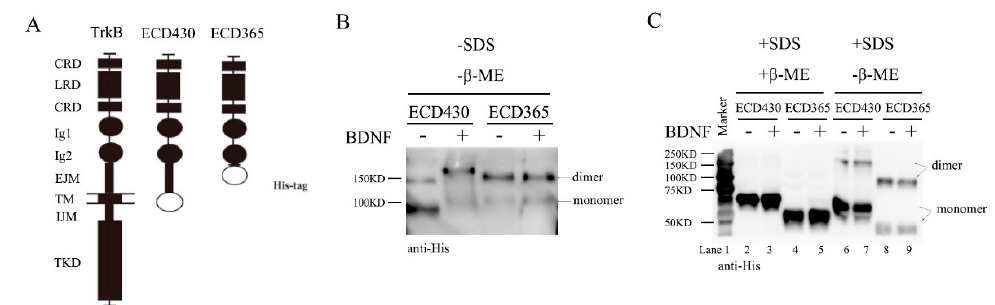
Figure 2. Removal of TrkB EJM facilitates dimer formation without BDNF. Recombinant TrkBECD365 or TrkBECD430 proteins (0.33 µ M) were incubated with BDNF (0.33 µ M) at 1:1 ratio in vitro overnight at 4 °C and Western blot was run in the presence or absence of denaturing or reducing agents. Approximately 50 ng of protein samples were loaded in each lane in either native or denaturing gels. These experiments were repeated at least three times and representative blots are shown. ( A ) from 30 to 430 while the ECD365 means from 30 to 365 (the open ellipses indicate the poly-histidine tags). ( B ). Differential effects of BDNF on ECD dimer formation, as shown by representative native-